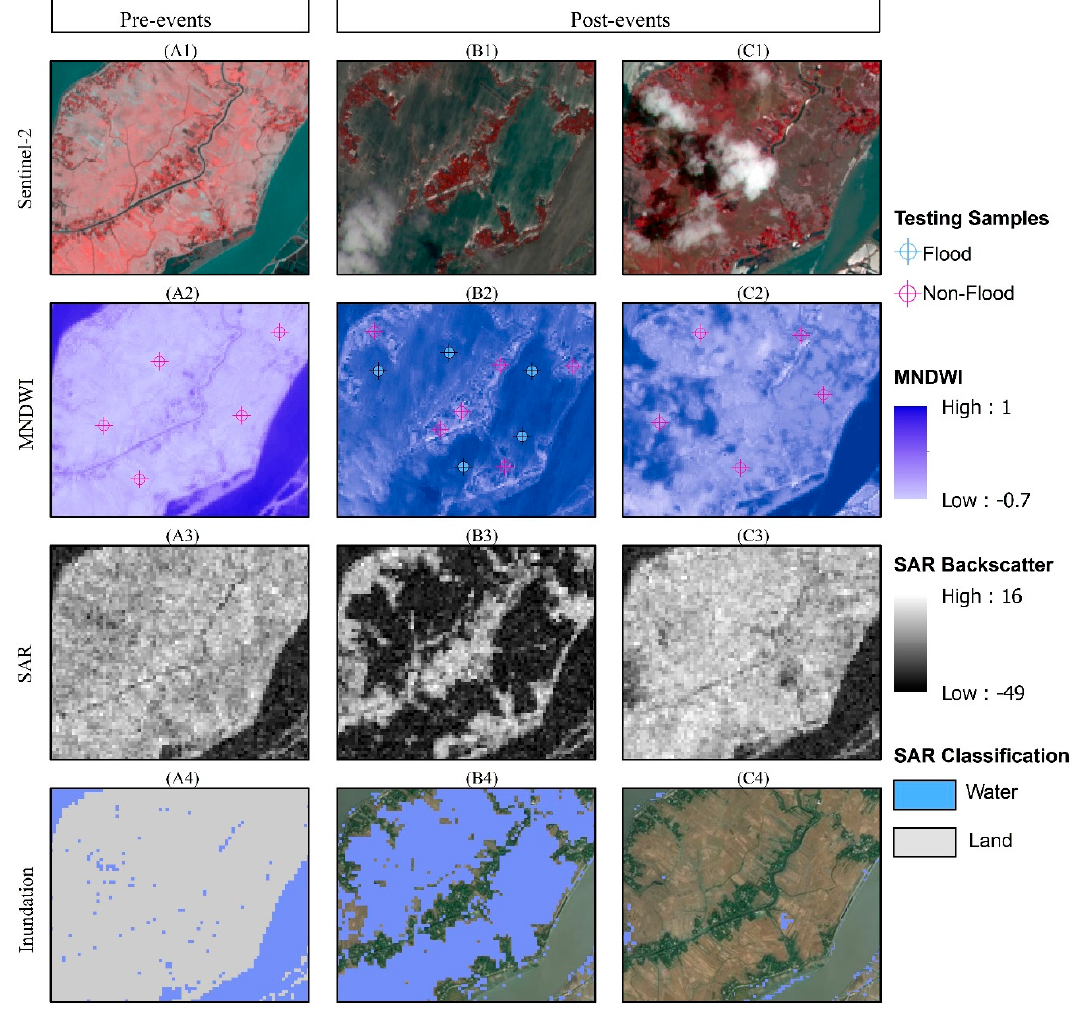
Figure A2. Comparison and validation of flooding extent for a subset of the region against Sentinel-2 and Google Earth Imagery. Map in ( A1 ) false-color composite images of Sentinel-2 for 16 May, ( B1 ) 25 May, and ( C1 ) 7 June. Map in ( A2 ), ( B2 ), and ( C2 ) corresponds to the computed MNDWI and testing samples sites. Similarly, A3 , B3 , and C3 represent the VV and VH composite SAR images of 16 May, 22 May, and 7 June. While the map in ( A4 ) shows the pre-Amphan SAR image classification, in ( B4 ) and ( C4 ) extracted flooding areas of 22 May and 7 June were imposed on Google Earth imagery.